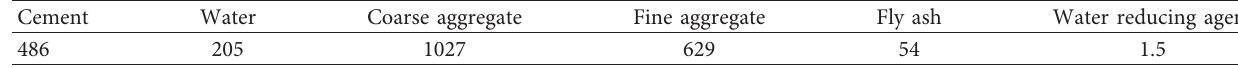
Table 1: Mix proportion of NPCC (kg/m 3 ).